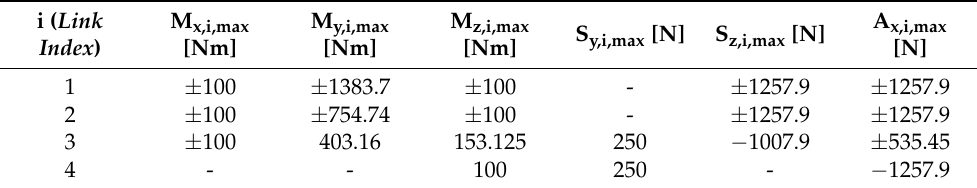
Table 4. Reference internal loads to use for sizing the